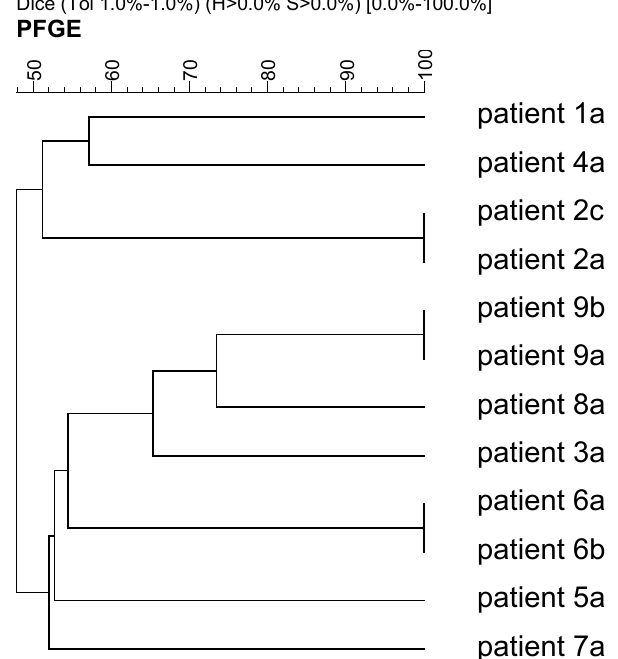
Figure 1. Dendrogram of Pseudomonas aeruginosa isolates from the respiratory tract and blood cultures. Horizontal axis—similarity of bacterial isolates (%); vertical axis—isolate number; letter a denotes isolates from endotracheal secretions, letter b denotes isolates from the upper respiratory tract and letter c denotes isolates from blood cultures.